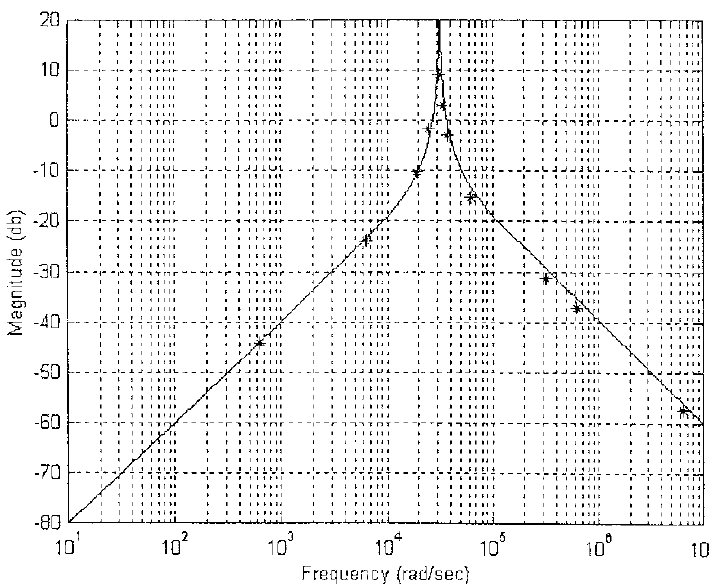
FIGURE 4 Calculated (____) and simulated (**) characteristics of the current-mode BPF obtained from I out 2 with V in 1 ¼ V in 2 ¼ I in 2 ¼ 0.